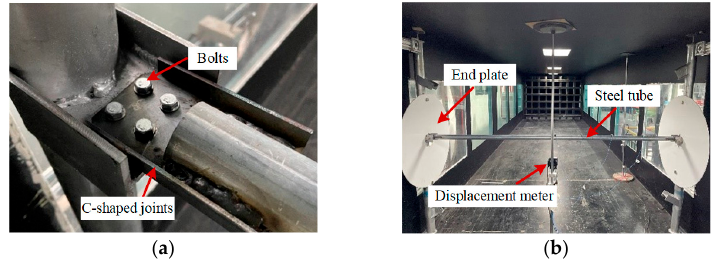
Figure 1. The overall experimental setups. ( a ) C-shaped connection joints; ( b ) Overall view.